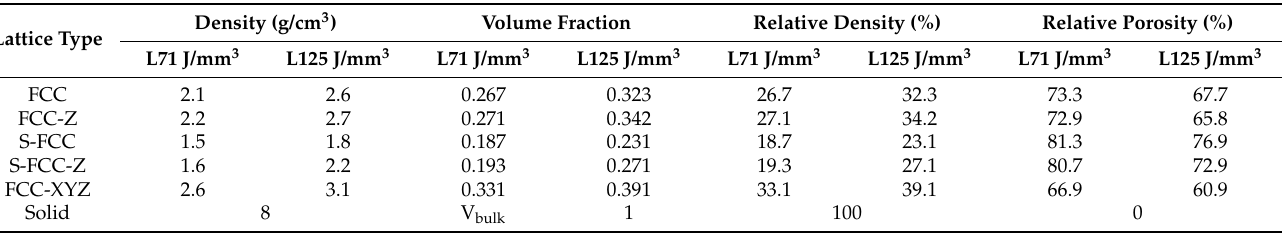
Table 4. Density and porosity of bulk SS316L FCC lattice